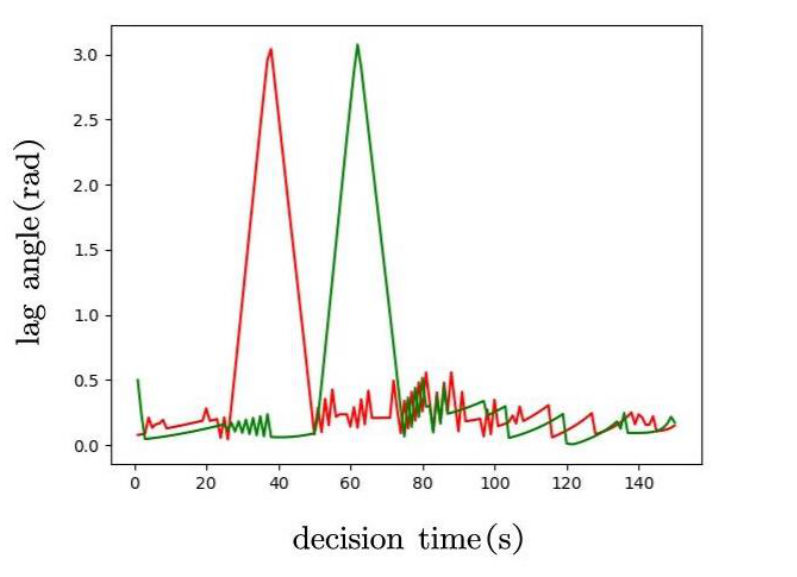
Figure 7. Change of the lag angle in the process of air combat.